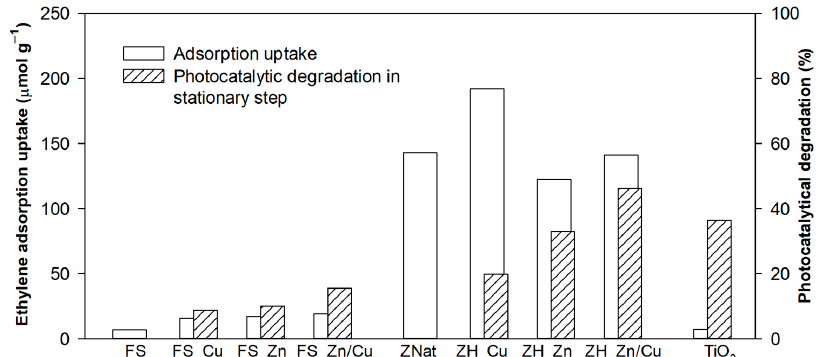
Figure 6. Ethylene adsorption and photocatalytic degradation results using parent zeolite support (ZNat), single metal oxide catalysts supported on modified natural zeolite (ZH_Cu; ZH_Zn), copper and zinc oxides supported on modified natural zeolite (ZH_Zn/Cu), raw fumed silica (FS), single metal oxide catalysts supported on fumed silica (FS_Cu; FS_Zn), and copper and zinc oxides supported on fumed silica (FS_Zn/Cu), and TiO 2 P25 mixed with fumed silica (FS_TiO 2 ). Curves of the ethylene dimensionless concentration at the reactor outlet stream as the function of time are displayed in Figure 5. The first 600 min of every curve represents the variation of ethylene dimensionless concentration during the adsorption step until saturation is reached (without irradiation). Adsorbed amounts of ethylene during the dy ‐ namic adsorption step onto the studied samples ( μ mol g − 1 ) are reported in Figure 6. Af ‐ can be seen, the stationary state of the photocatalytic step is attained after a few minutes.